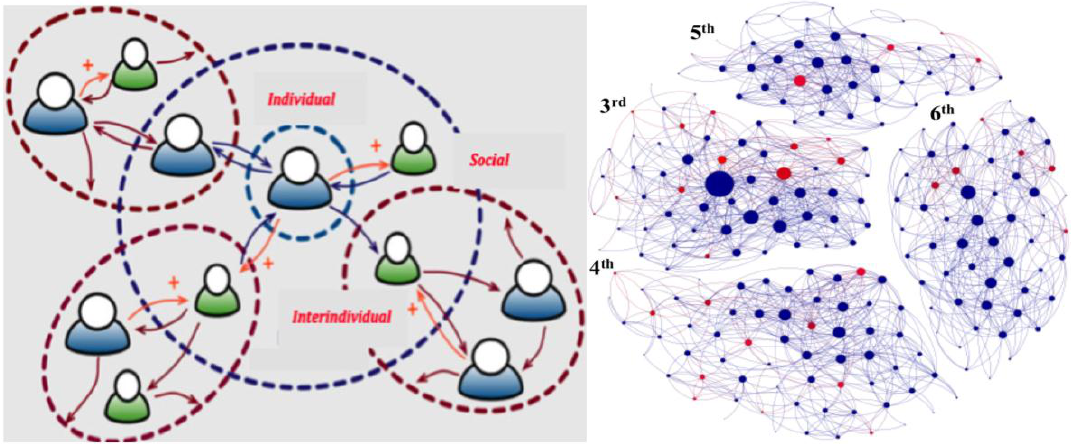
Figure 6. Left: inter-individual relationships in a social context. Right: friendship networks in the 6th (12 y) to the 3rd (15 y) class of a French high school. Vertex size is proportional to the friends’ number: normal in blue, obese and overweight in red.